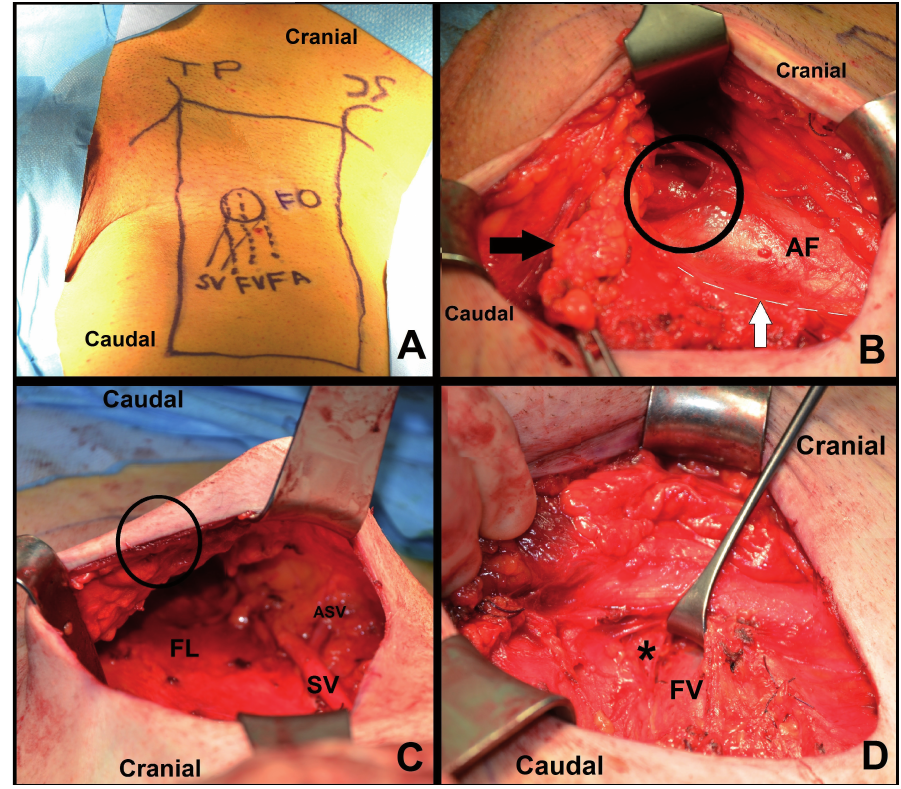
Figure 1 - (A) Preoperative view of the left groin with dissection borders and selected anatomic structures marked on the skin. (B) Cranial extension of the dissection field. Circle - external inguinal ring, arrow - lymphatic tissue being removed, white dotted line with white arrow - inguinal ligament. (C) Caudal dissection area with thick skin flaps preserved (circle). (D) Deep inguinal nodes (asterisk) are being dissected in the femoral